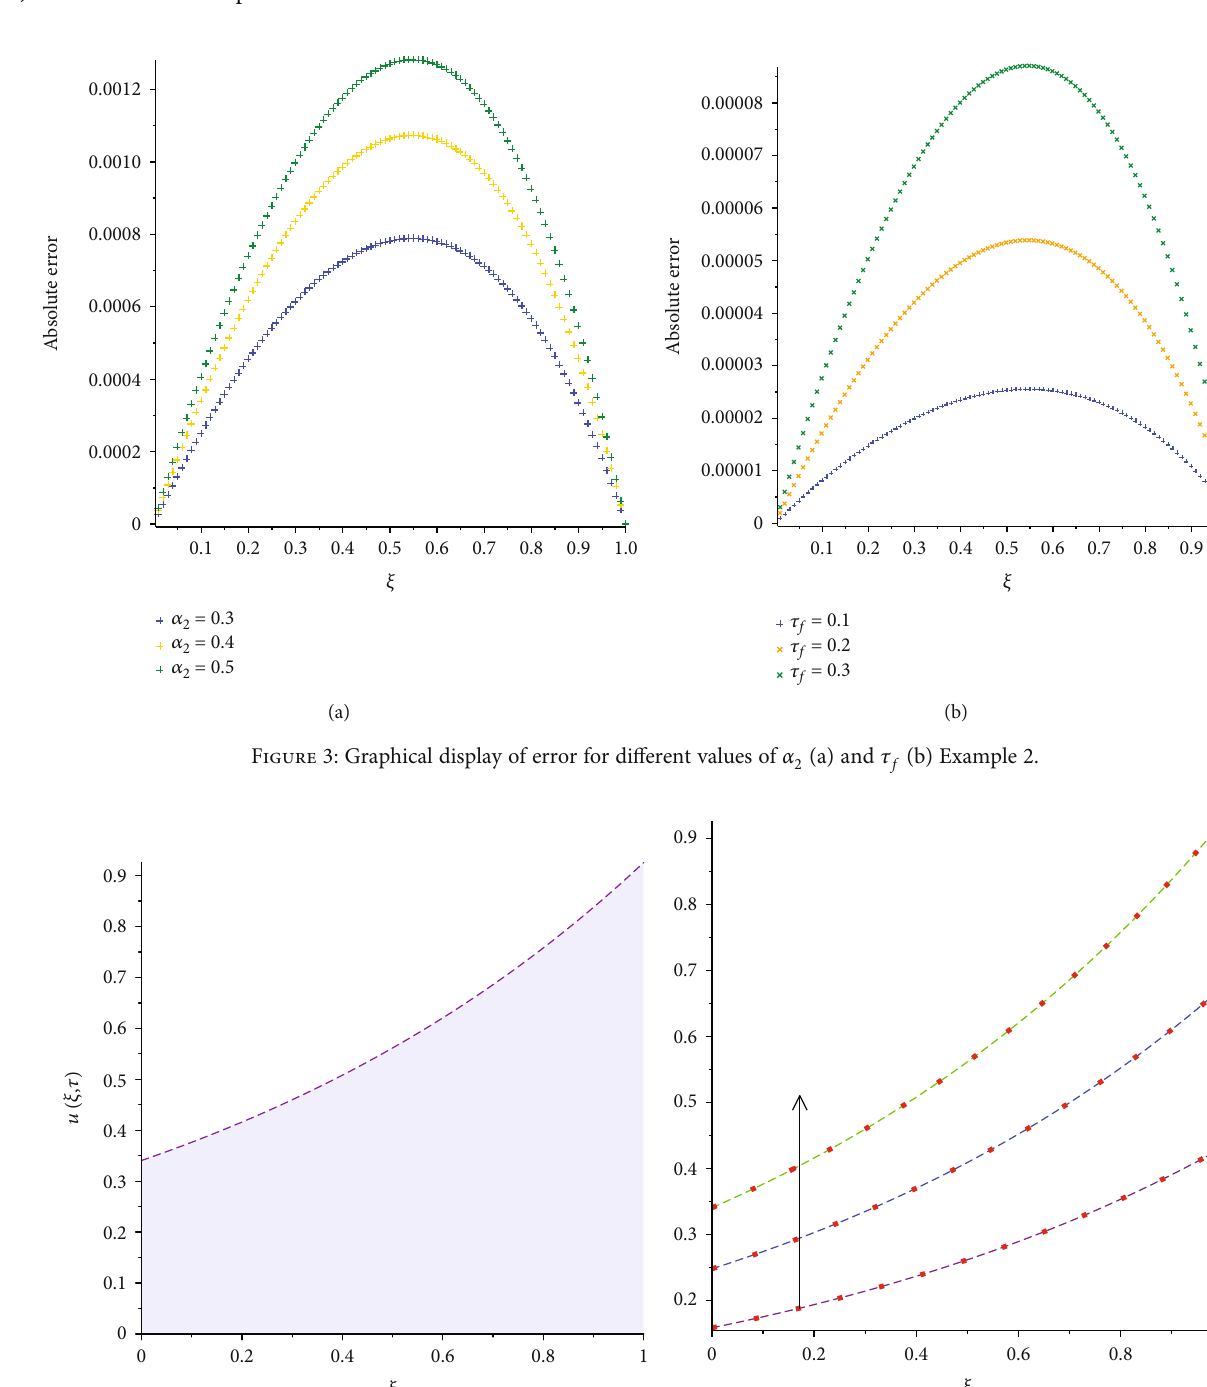
Approximate solution for t = 0.1